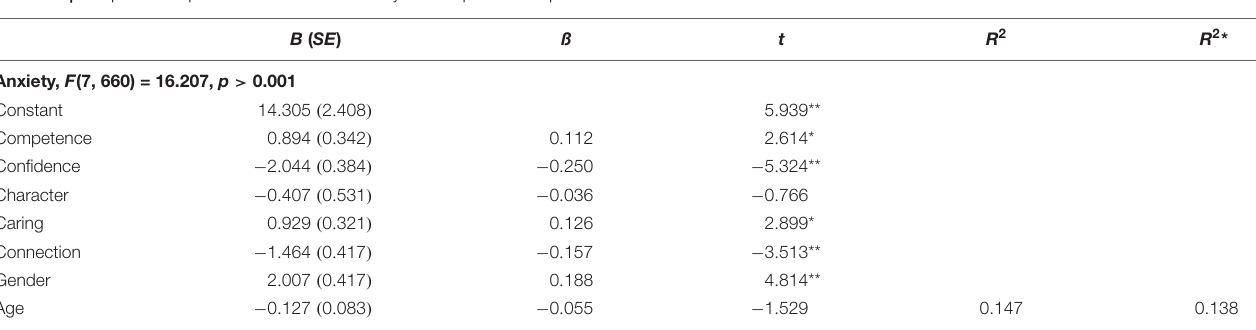
TABLE 6 | The predictive power of the 5Cs for anxiety in the Spanish sample. B ( SE )